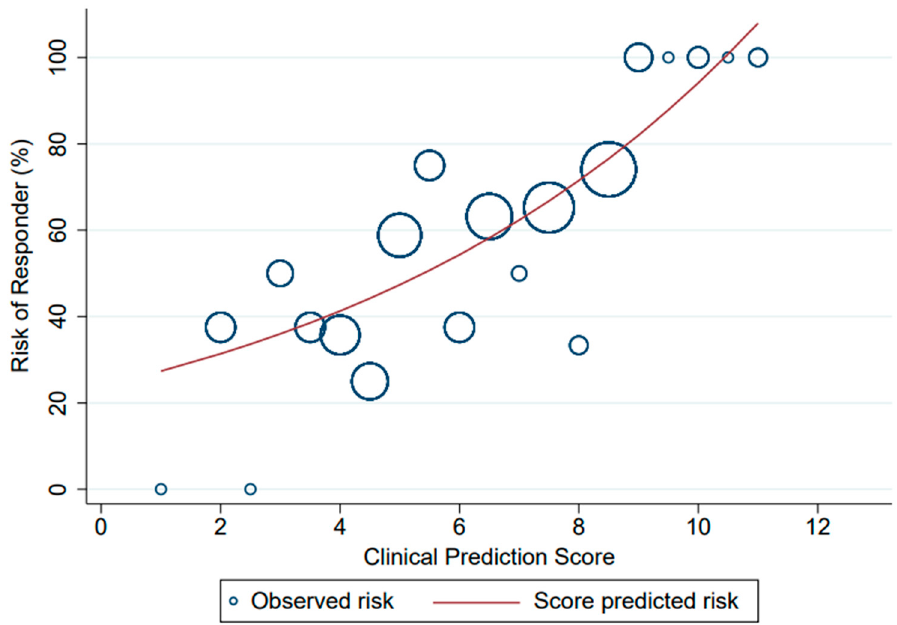
Figure 3. Observed risk (circle) versus score-predicted risk (solid line) of responder probability.